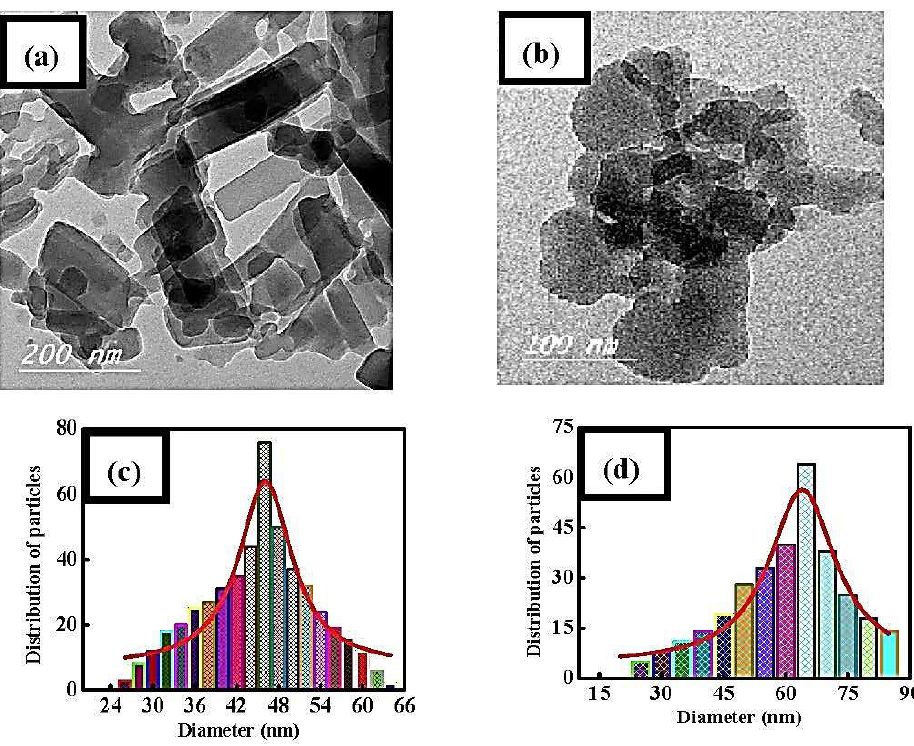
Figure 2. ( a , b ) Transmission electron microscopy (TEM) images of the ahpvCu and ahpvNi complexes, and ( c , d ) their calculated histograms, respectively.